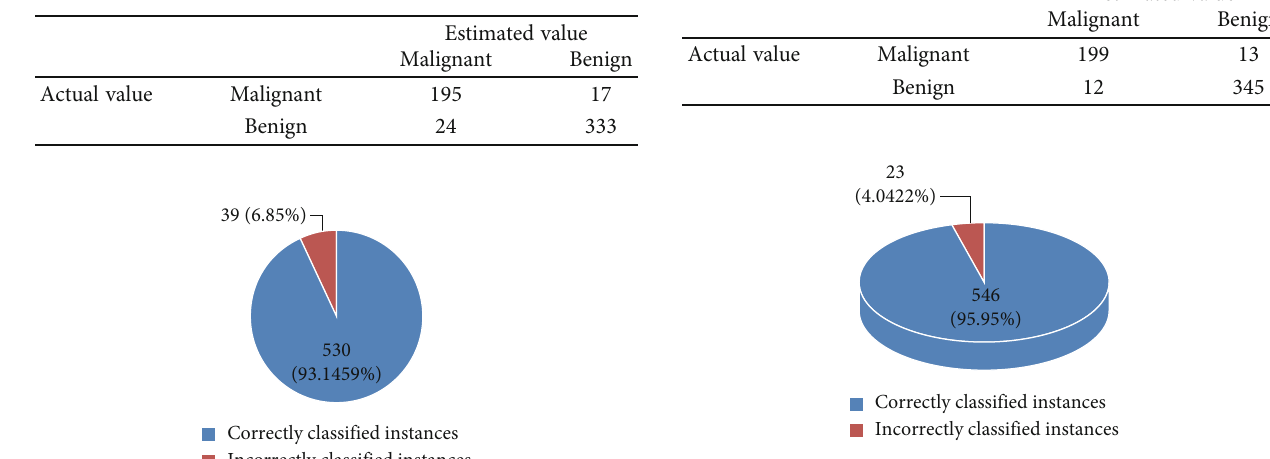
Figure 11: Percentages of success of the KNN